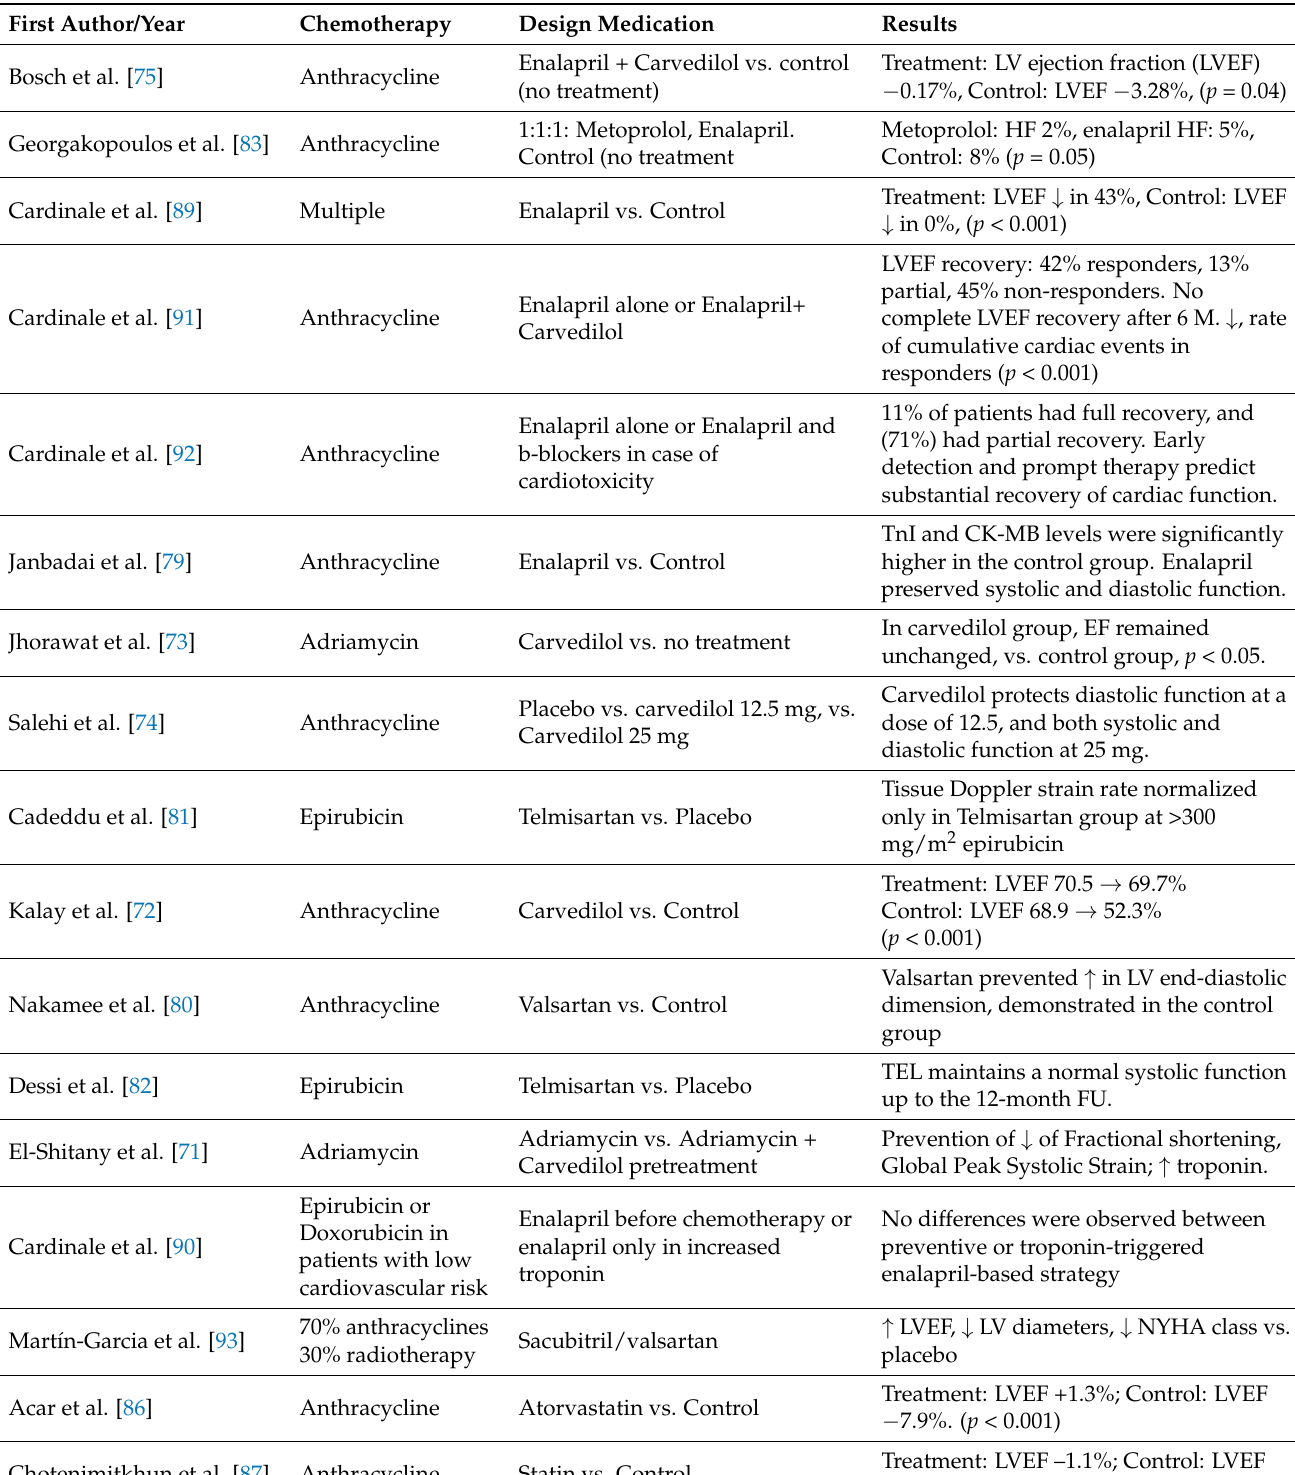
Table 3. Trials evaluating preventive strategies with cardiovascular drugs in patients with hemato- logic